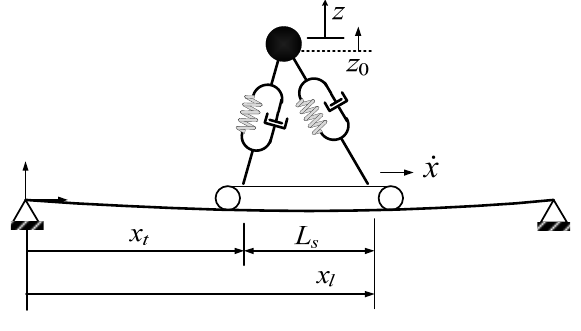
Figure 3. Assumption of stepping in a fixed position.